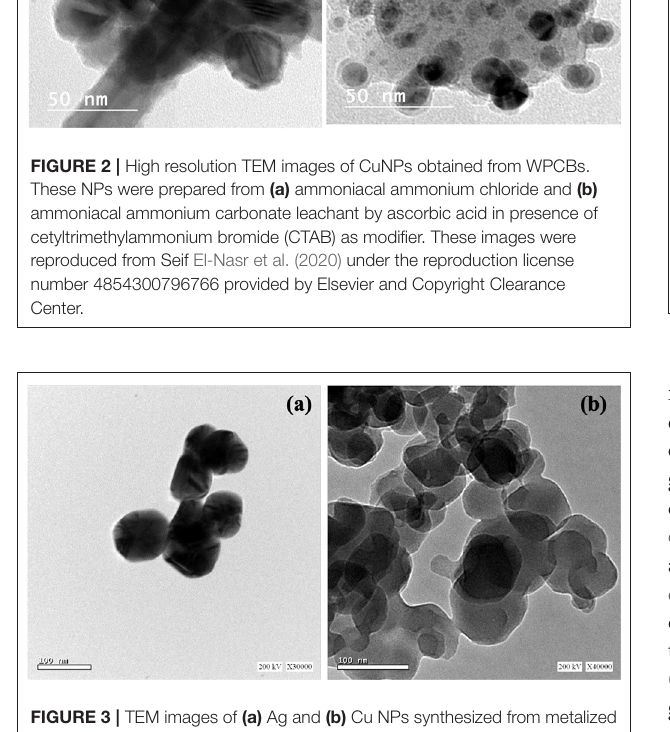
FIGURE 3 | TEM images of (a) Ag and (b) Cu NPs synthesized from metalized plastic waste. The NPs were prepared with leachant solution of metalized acrylonitrile butadiene styrene (ABS) using ascorbic acid as reductant and chitosan as stabilizer according to the methods described by Elsayed et al. (2020) . These original images were provided by the authors of the manuscript and have not been previously published.